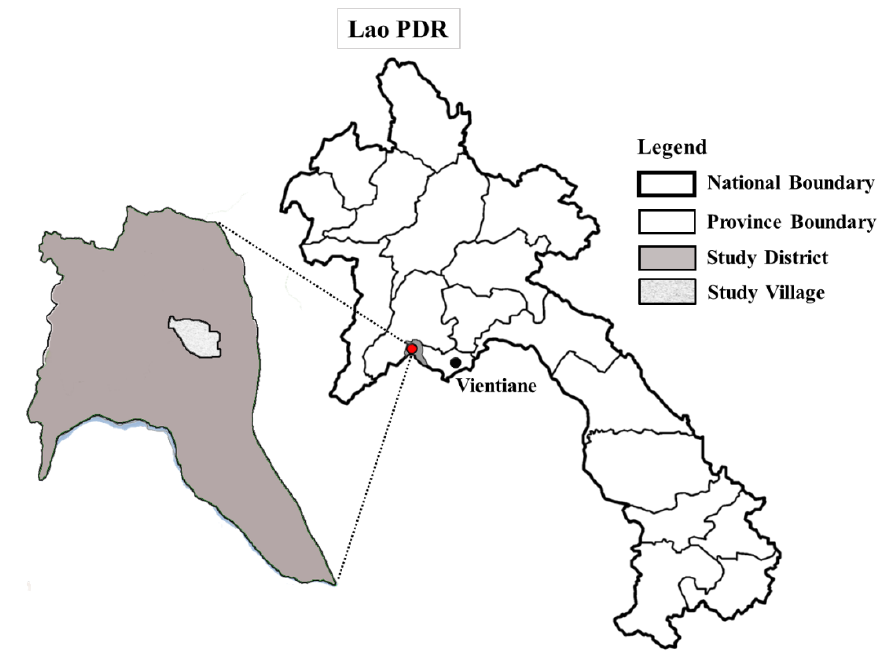
Figure 1. Location of the project site in Sangthong district.